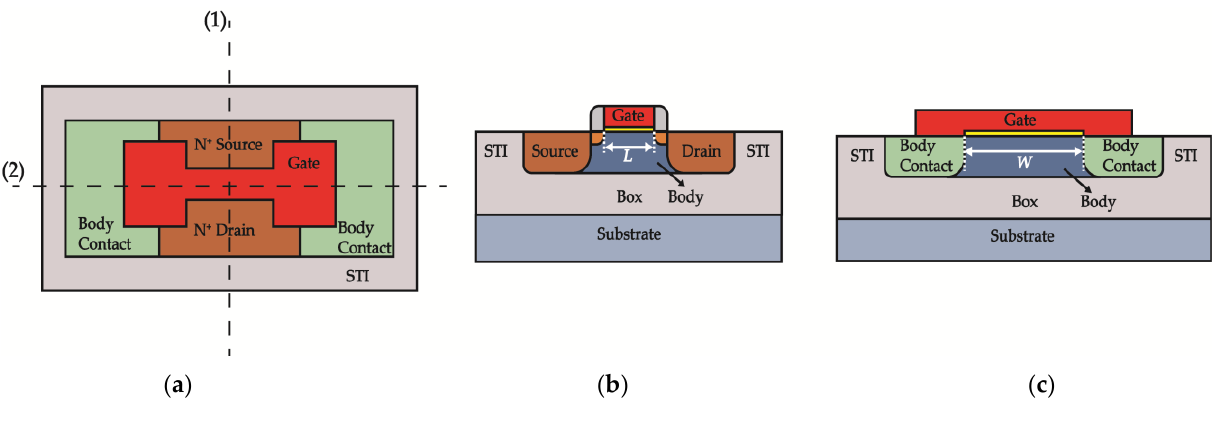
Figure 1. ( a ) Layout of measured devices. ( b ) Cross-sectional view of measured devices along the dashed line (1) in ( a ). ( c ) Cross-sectional view of measured devices along the dashed line (2) in ( a ).